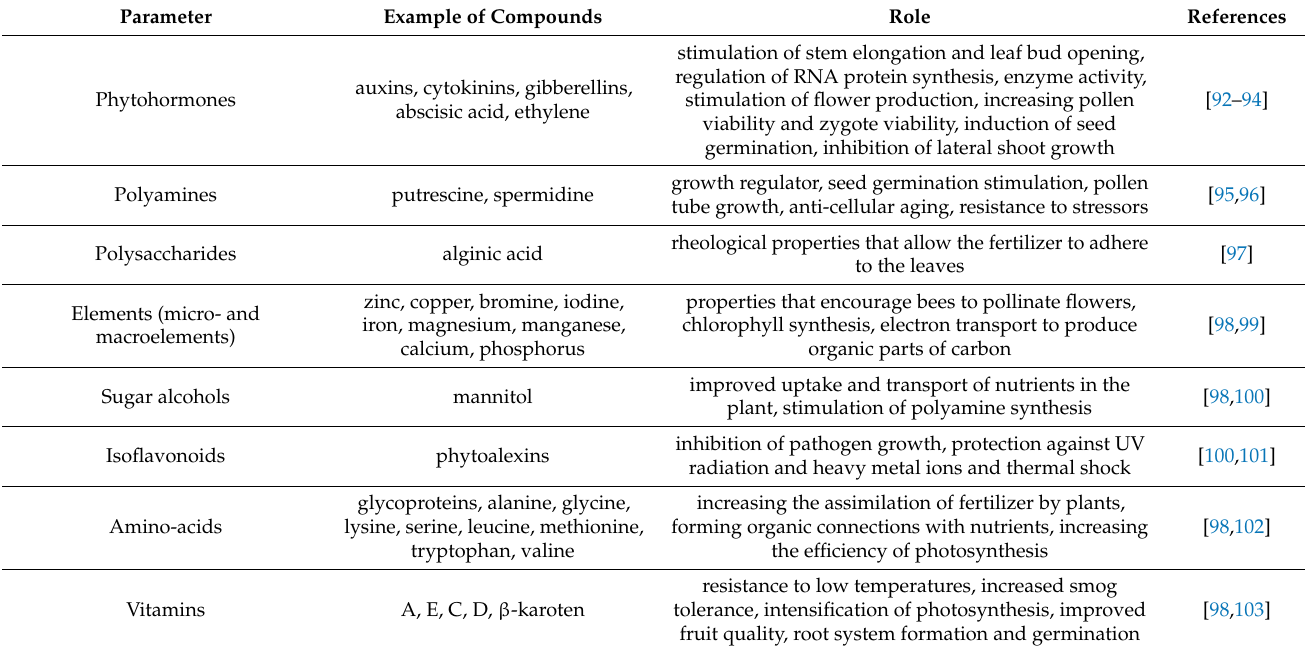
Table 13. Chemical compounds present in algae with an indication of their role in fertilization (authors’ own